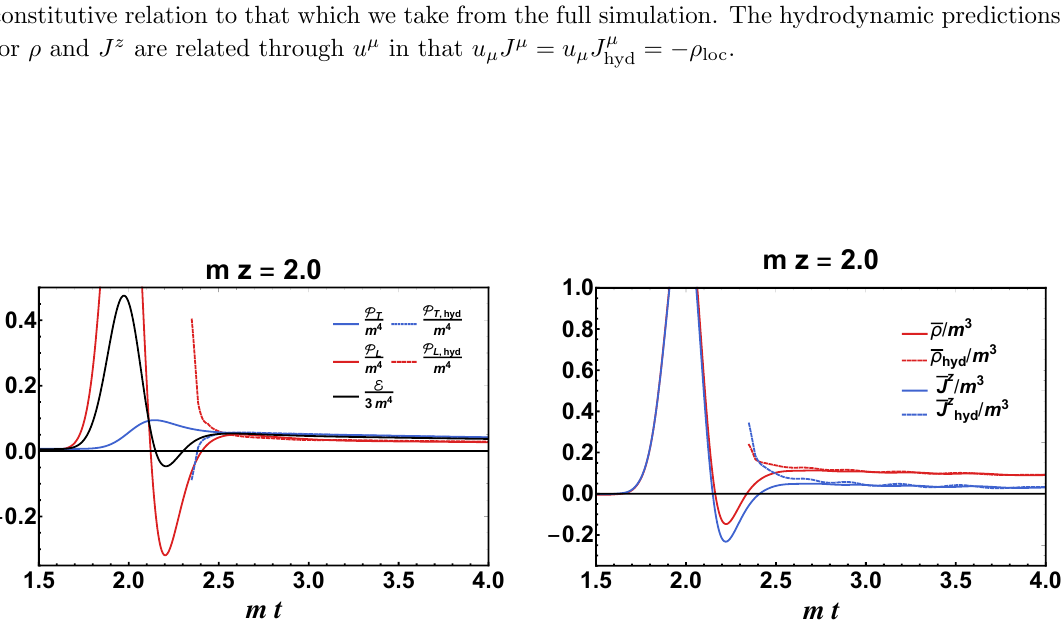
= (cid:0) 0 : 2 and (cid:12) = 0 : 05. The GB